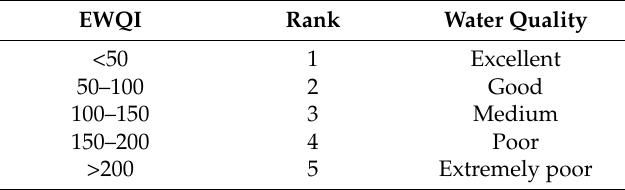
Figure 10. Bivariate diagram of entropy weighted water quality index (EWQI) versus TDS. Table 2. Classification criteria of groundwater quality base on EWQI.